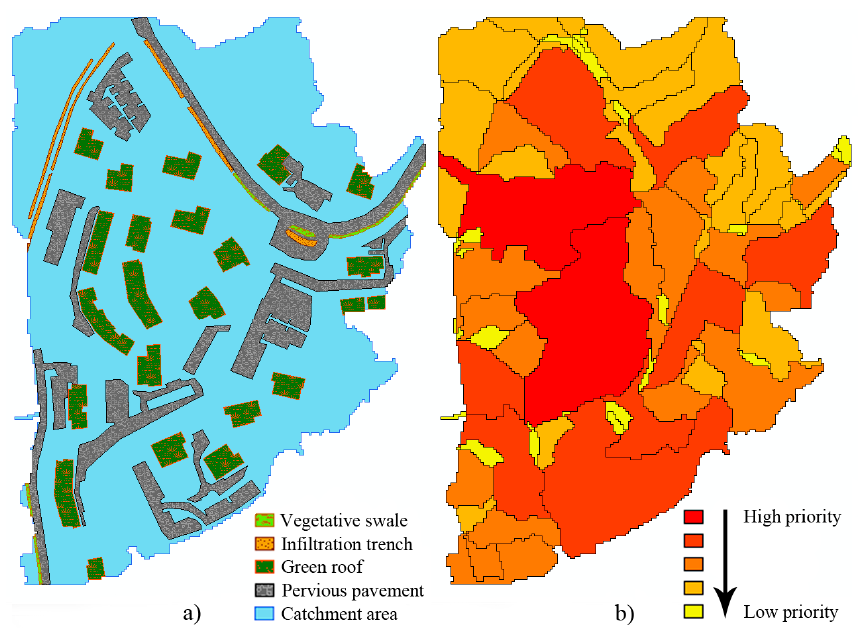
Figure 6. ( a ) Feasible areas for the location of the main types of Sustainable Drainage Systems (SuDS); and ( b ) subcatchment prioritization according to the values of peak runoff calculated in the stormwater simulations.